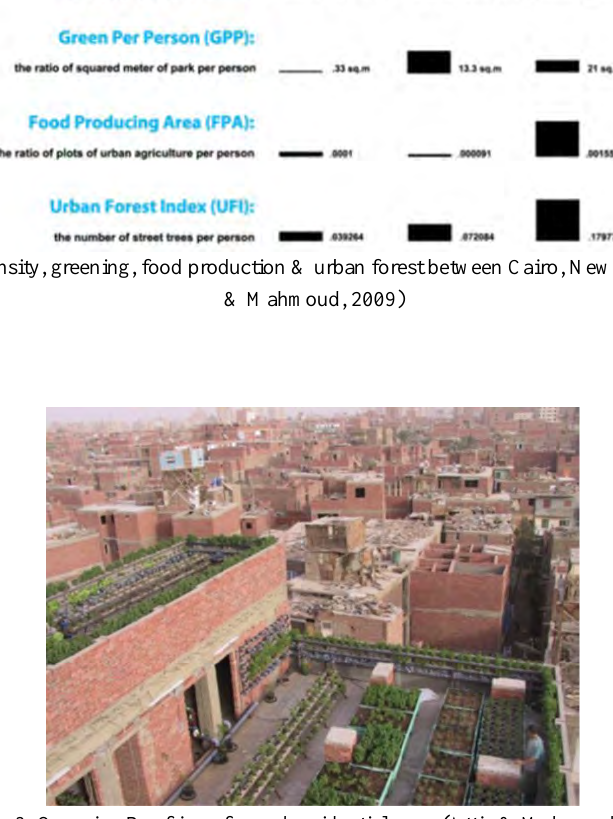
Figure 3. Greening Roof in unformed residential zone (Attia & Mahmoud,